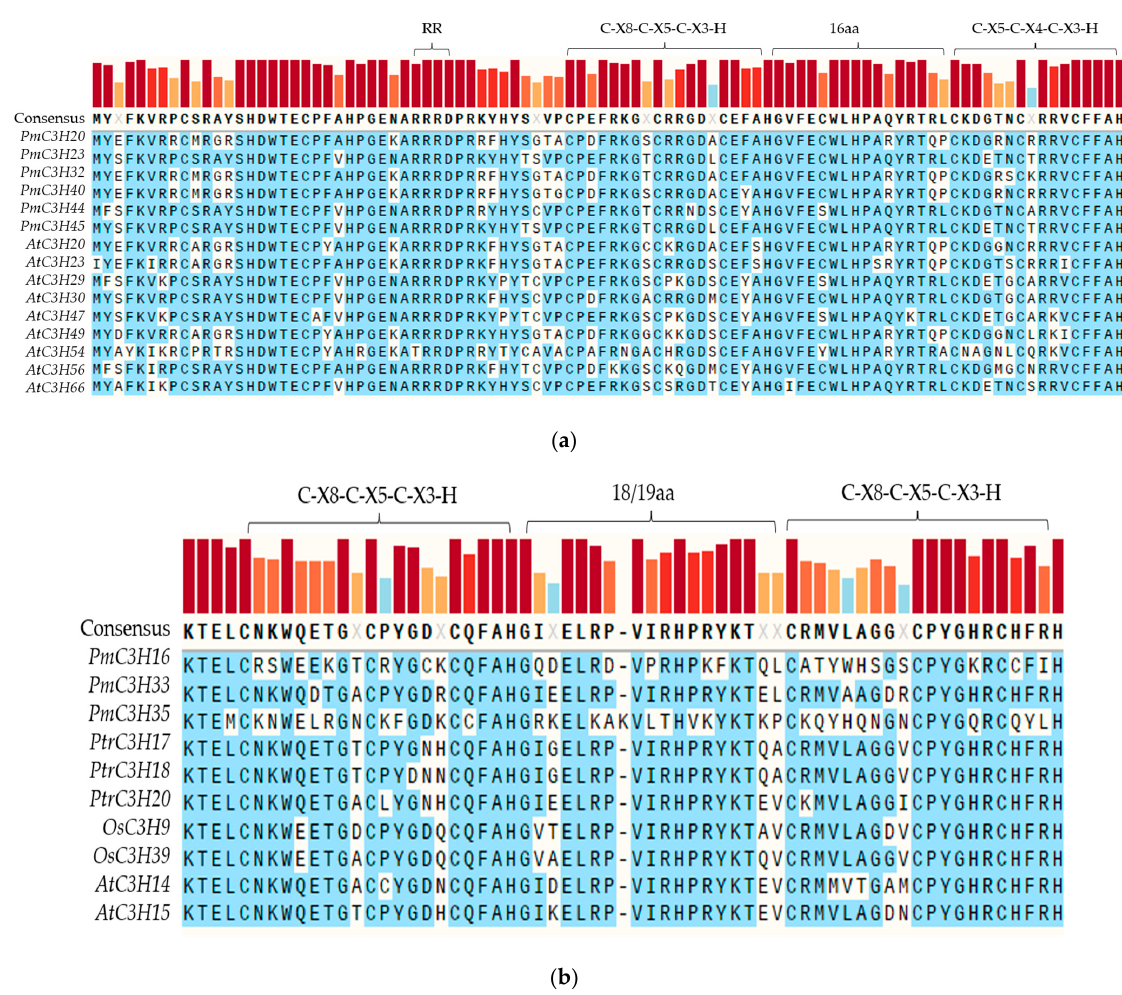
Figure 3. Multiple sequence alignment of different TZF proteins. ( a ) RR-TZF proteins in P. massoniana and A. thaliana , ( b ) typical tandem zinc finger (TZF) domain in P. massoniana , P. trichocarpa , O. sativa and A. thaliana .